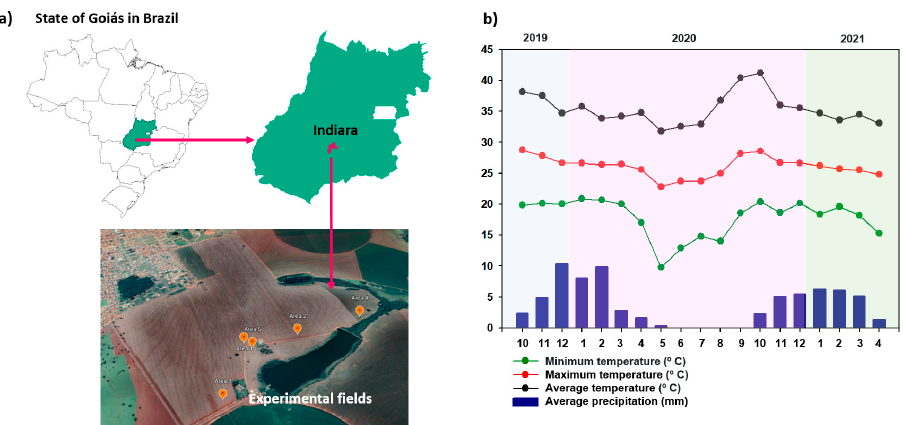
Figure 1. Location of five experimental fields in the municipality of Indiara, interior of the state of Goiás, Brazil ( a ) and observed data for minimum, average, and maximum temperatures and average rainfall during the summer crops 2019/2020 and 2020/2021 ( b ). Data source: agritempo.gov.br (accessed 20 January 2022).